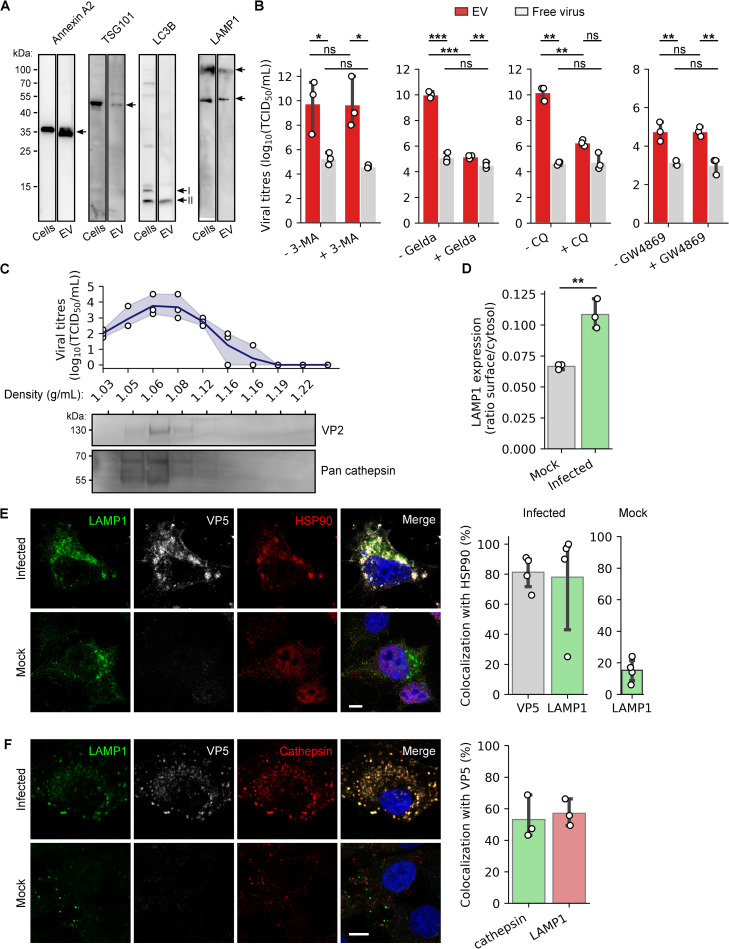
Infectious EVs rely on MVBs and late autophagy.(A) Western blot detection of cellular proteins Annexin A2, TSG101, LC3B and LAMP1 in infected sheep cell lysates and EVs secreted from these cells. (B) Infectivity of the EVs and free virus particles fractions, released from infected sheep cells in presence or absence of 3-MA, geldanamycin, CQ or GW4869. Data are presented as mean ± SD. Each point indicates the value of independent replicates (N = 3, unpaired t-test, ns p>0.05, *p<0.05, **p<0.01, ***p<0.001). (C) Infectivity measured (top panel) and proteins detected (VP2 and cathepsins, bottom panel) by western blot in each fraction after isopycnic ultracentrifugation of the EVs containing BTV particles. The density (g/mL) measured in each fraction is indicated on the x-axis. Each point indicates the value of independent replicates (N = 3), the continuous line represents the mean viral titre and the translucent error bands represent the confidence interval. (D) LAMP1 surface expression ratio, in mock and BTV infected cells. Data are presented as mean ± SD. Each point indicates the value of independent replicates (N = 3, unpaired t-test, **p<0.01;). (E-F) Microscopy images of mock or BTV infected sheep cells labelled with anti LAMP1, VP5 and (E) HSP90 or (F) pan-cathepsin antibodies. Scale bar: 5 μm. Right panels show (E) the percentage of VP5 and LAMP1 co-localising with HSP90, and (F) the percentage of VP5 co-localising with cathepsins and LAMP1 in infected cells.